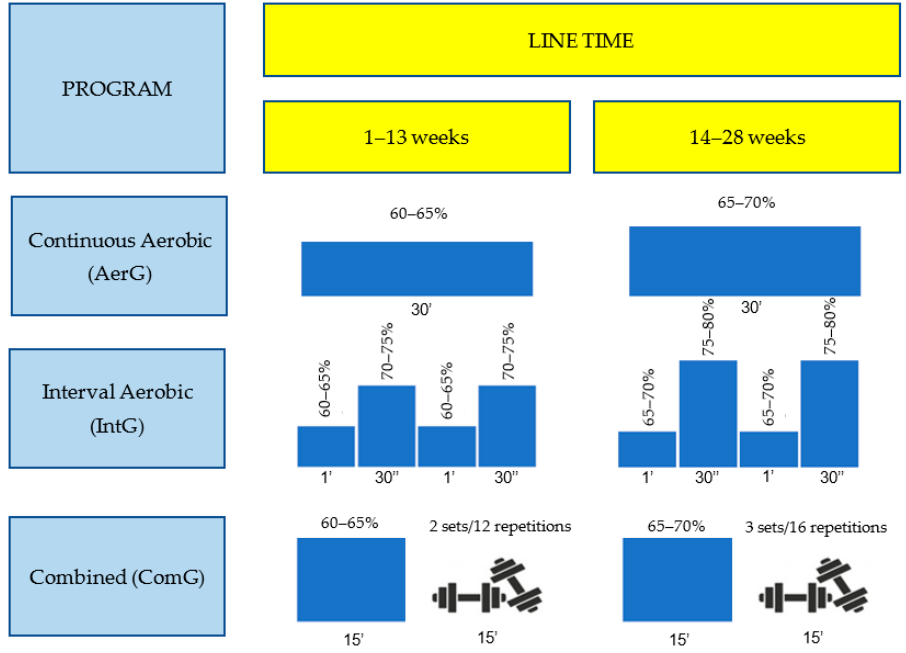
Figure 2. Characteristics of the main part for the three physical exercise aquatic programs (continuous aerobic, interval aerobic, and combined).